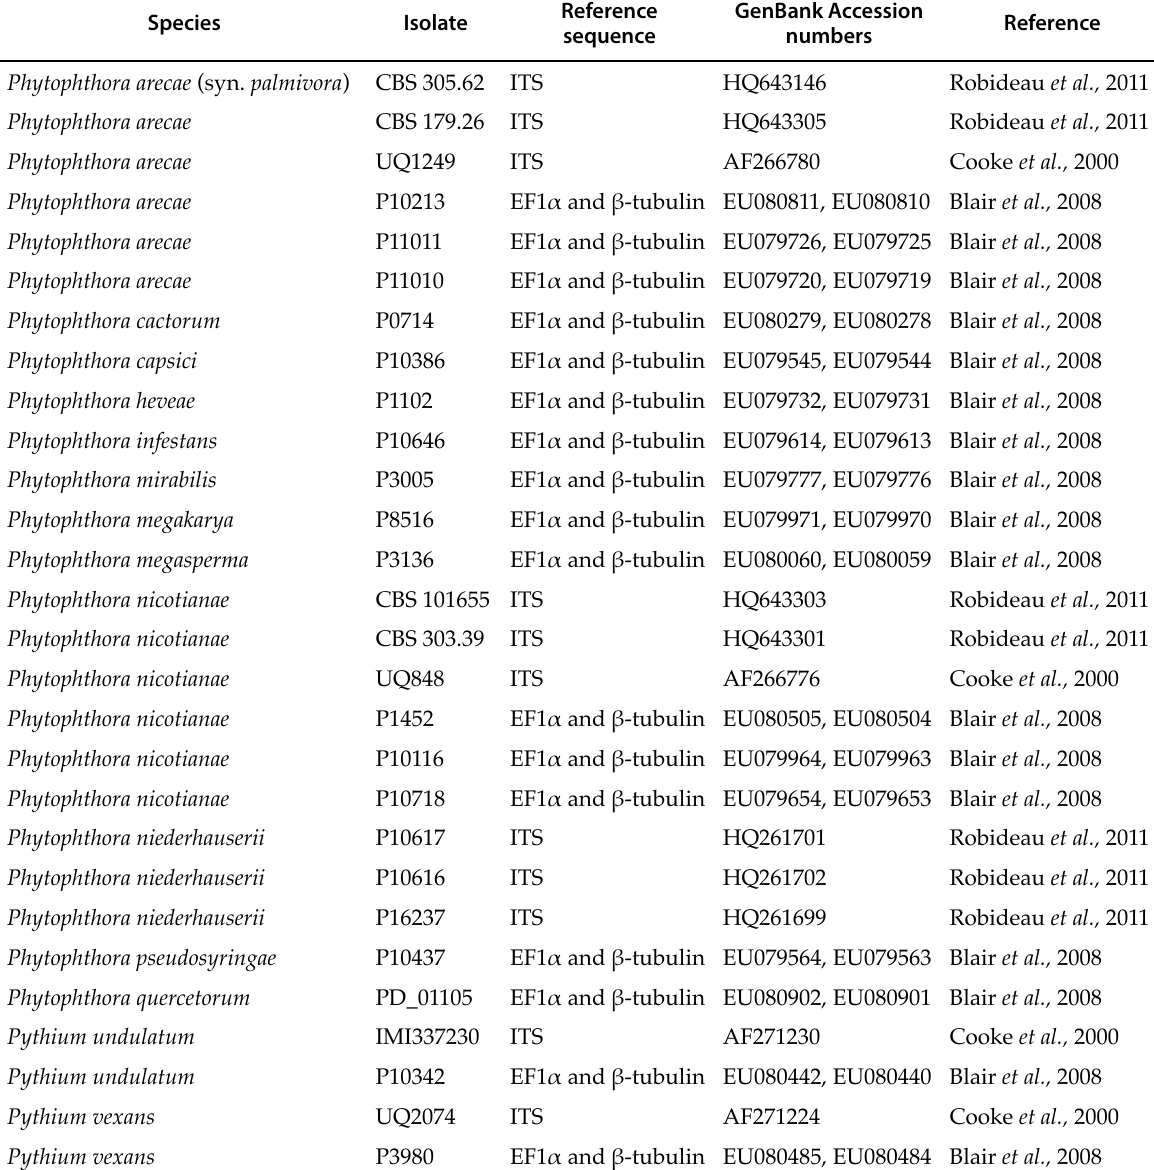
Table 3. Reference isolates used to construct phylogenetic